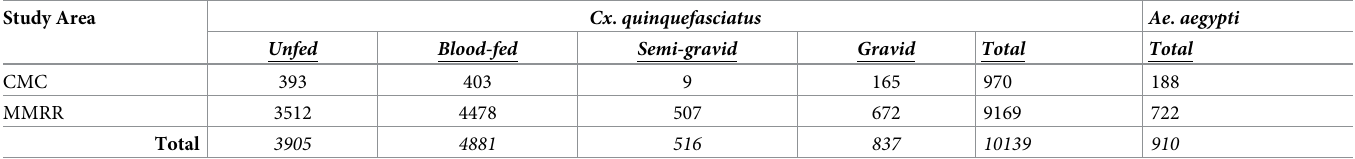
Table 3. Total numbers of female Cx . quinquefasciatus and Ae . aegypti mosquitoes captured in CMC and MMRR experiments, Sı´tio Novo, Olinda, RMR, Brazil, July 22–August 21, 2015. Study